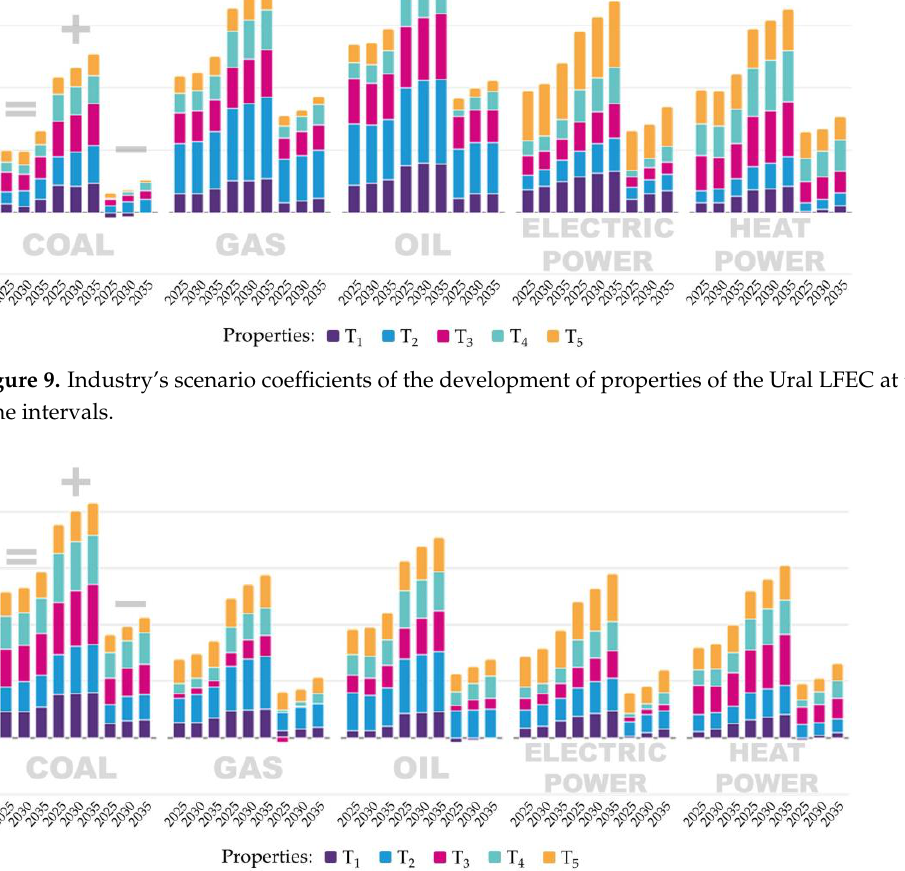
Figure 11. Industry’s scenario coefficients of the development of properties of the Eastern LFEC at three time intervals. In all charts, the columns representing the sum of the coefficients of T i properties are divided into five groups by the energy industry. The first nine columns describe the coal industry, and the next nine columns describe the gas industry, followed by oil, electricity and heat energy. In each group, the first three columns describe the obtained coefficients for the neutral scenario, the next three for the positive scenario, and the last 3 columns for the negative scenario. The significance of the contribution of one of the five properties to the development of a particular energy sector under the chosen scenario at a certain time interval is deter- mined by the proportion of the corresponding color in the column under consideration. For example, the development of the electric power industry of the Central LFEC under neutral and positive scenarios at all time intervals is mostly influenced by reliability (T 5 ). High values of the obtained property coefficients indicate the potential for growth in the level of development of the industry. On this basis, an almost linear increase in the values of the coefficients of properties in industries, observed in some cases, reflects re- gions that prevail in the rate of their development. These rates are related to both the ex- ternal background and the internal level of technological development.